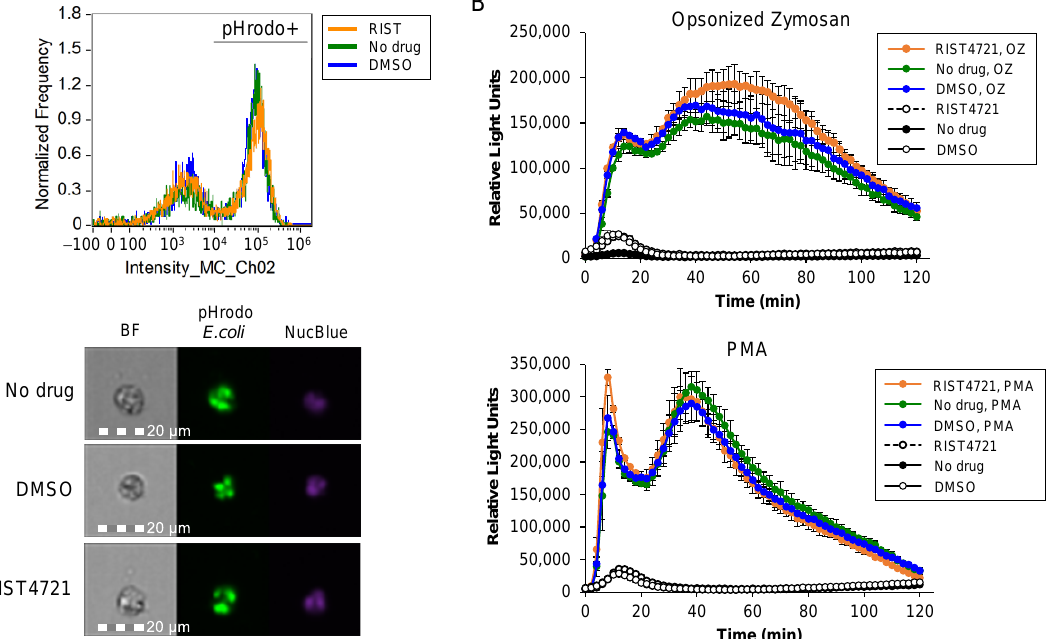
Figure 6. Phagocytosis and ROS production of neutrophils after treatment with RIST4721. ( A ) Shown are quantitative measurements of neutrophils that have phagocytosed E. coli particles that emit fluorescence when exposed to the acidic environment of the phagosome (upper panel), or images of cells with engulfed particles (lower panels), each obtained with imaging flow cytometry. ( B ) Graphed are data from analyses of ROS production by neutrophils that are treated with RIST4721 vs. no drug or DMSO, stimulated with either opsonized zymosan (upper graph) or PMA (lower graph), and measured using the enhanced luminol Diogenes. Data shown are averages ± SD from triplicate tests.